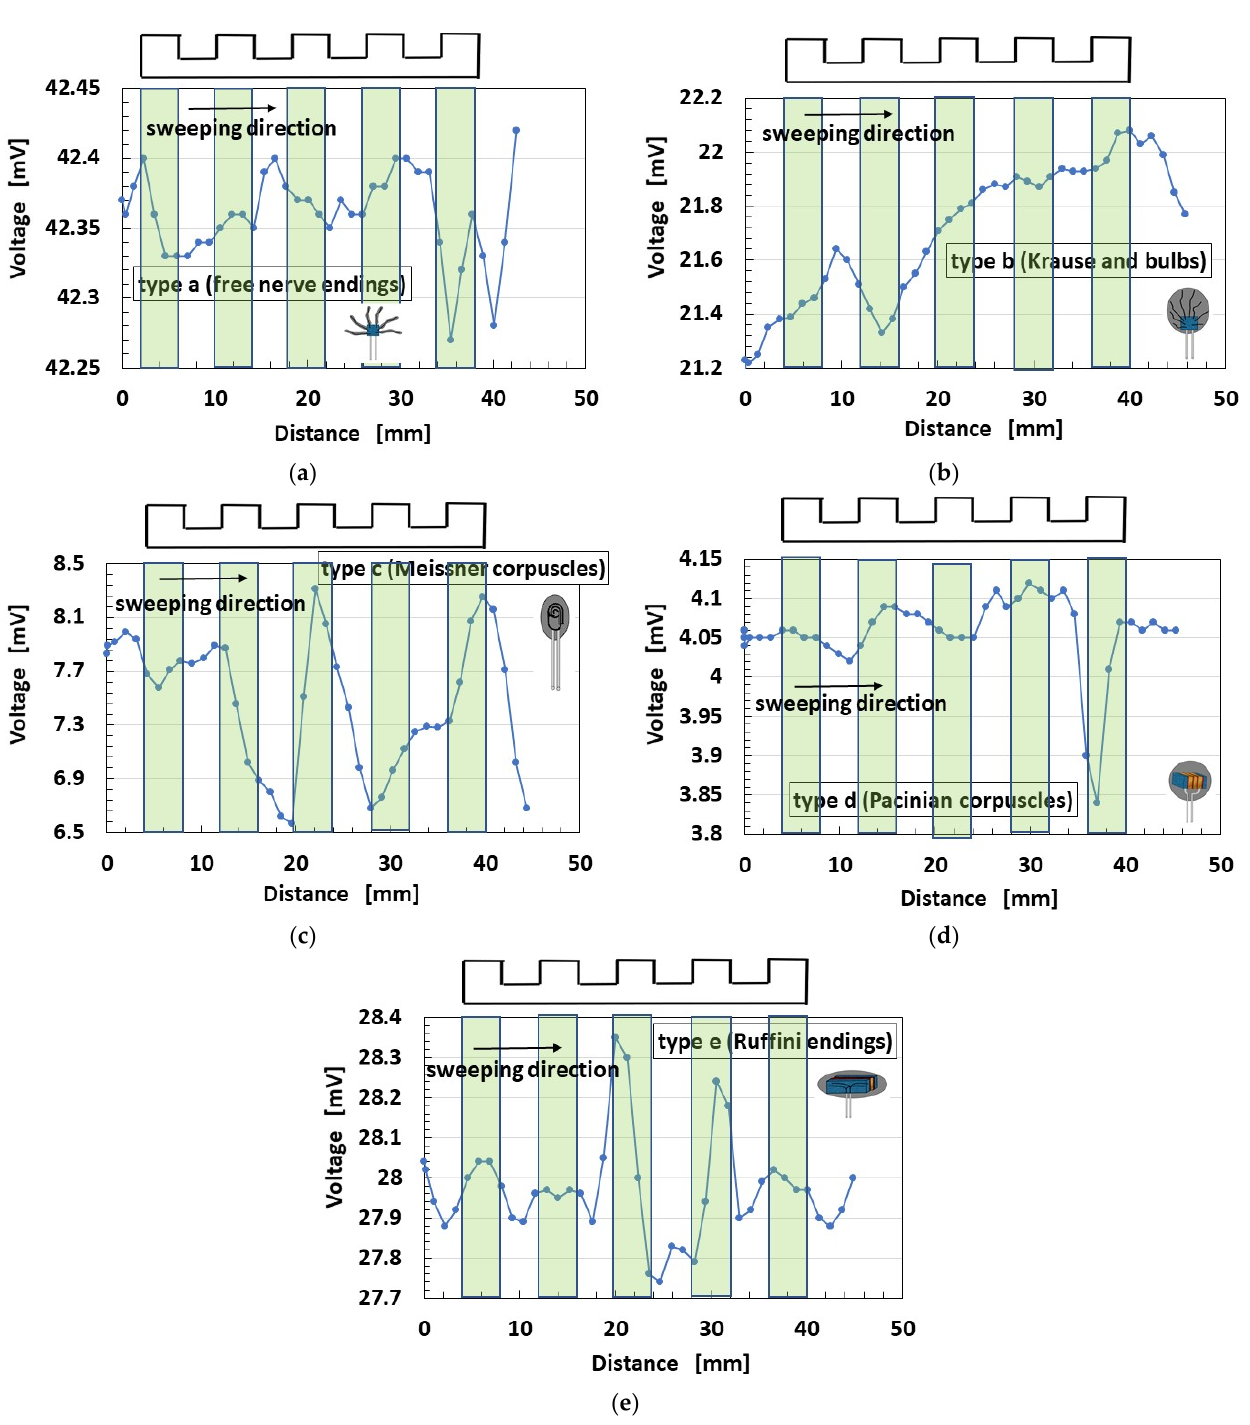
Figure 19. Voltage of each of the cutaneous receptors at shear motion on a concave and convex body: ( a ) Type A; ( b ) Type B; ( c ) Type C; ( d ) Type D; ( e ) Type E.